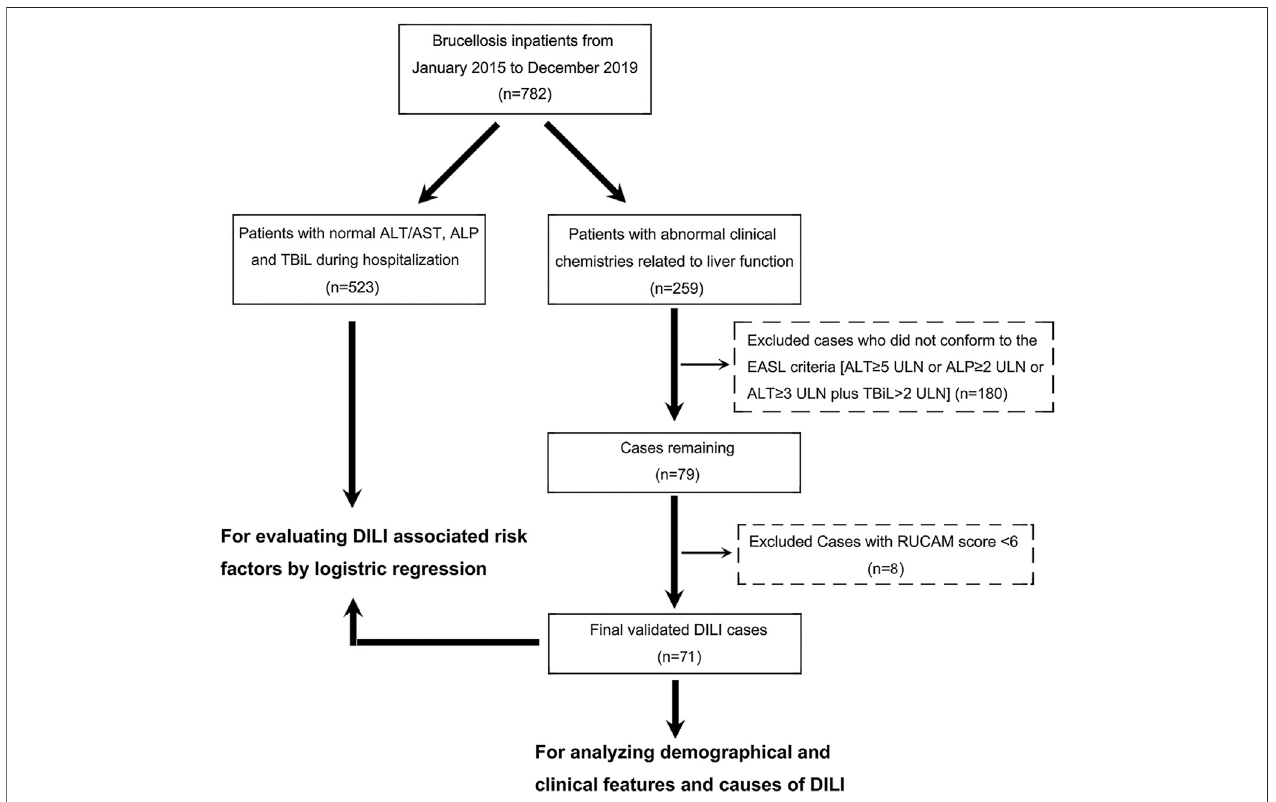
FIGURE 1 | A fl ow diagram showing the recruitment of brucellosis-associated DILI patients in this study during a 5 year observation period at the Shawan County People ’ s Hospital (2015 – 2019).